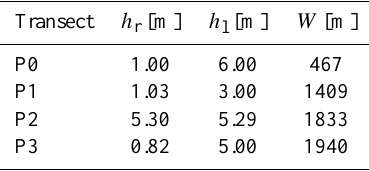
Table 1. Cross-reef profile characteristics at different